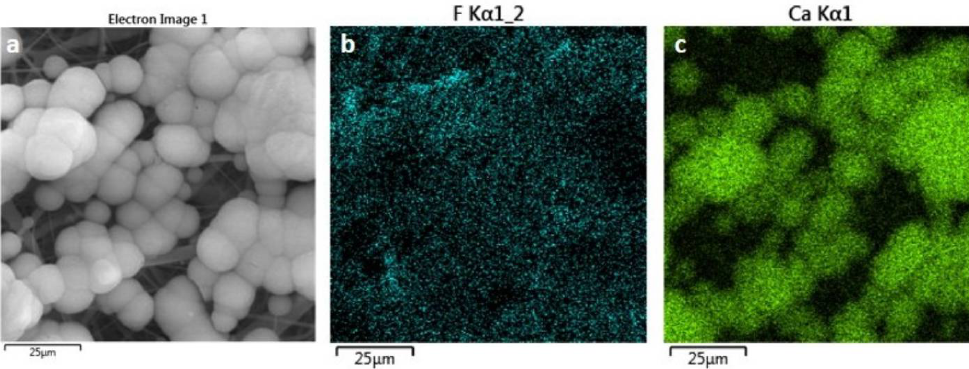
Figure 2. ( a ) SEM images obtained with secondary electrons detector for the P14-H10 sample. ( b , c ) EDS mapping of the region presented in ( a ) for F and Ca elements,